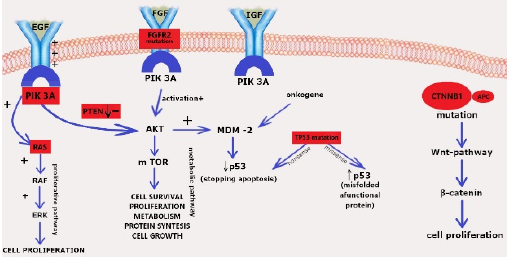
Figure 4 . The main pathways involved in carcinogenesis in the studied group. The Kaplan-Meyer curves for TP53, MLH-1, MSI, and FGFR-2. TP53 χ 2 = 3,90545 p = 0.14190, MLH-1 log-rank p = 0.53799, MSI log-rank p = 0.14569, and FGFR-2 log-rank p = 0.07095. p = 0.53799, MSI log-rank p = 0.14569, and FGFR-2 log-rank p =